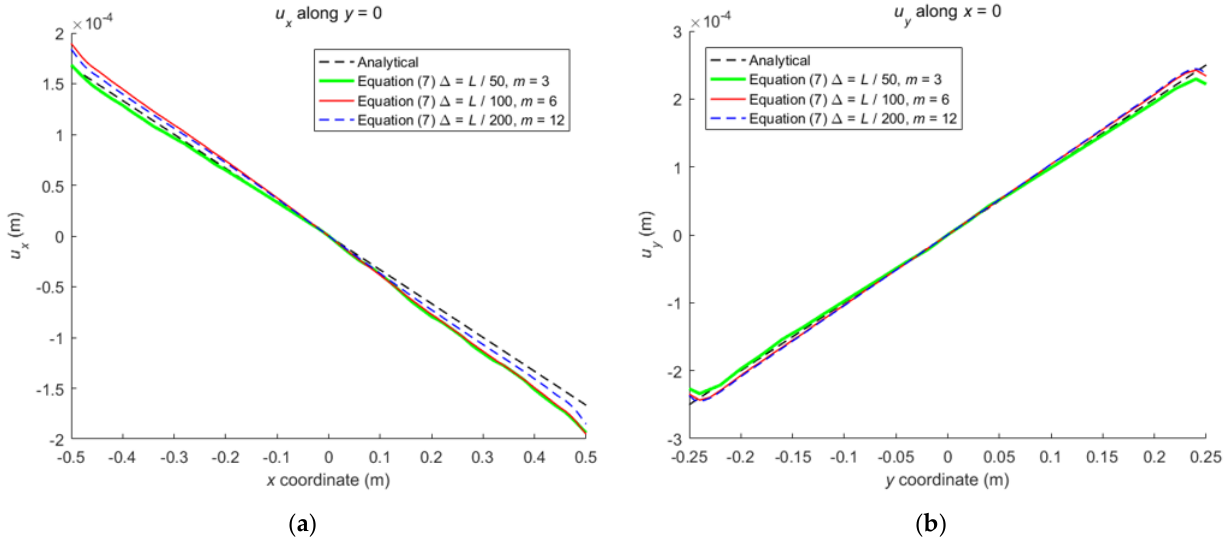
Figure 6. The displacements along central lines of the rectangular plate for three different combina- tions: ( a ) u x along y = 0; ( b ) u y along x = 0.